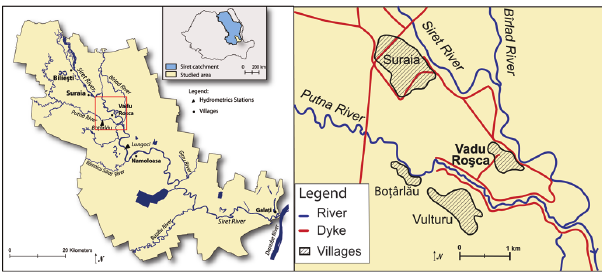
Fig. 2. Example of damaged houses in Vadu Ros¸ca after the flood of July 2005 (pictures: F. Salit, June